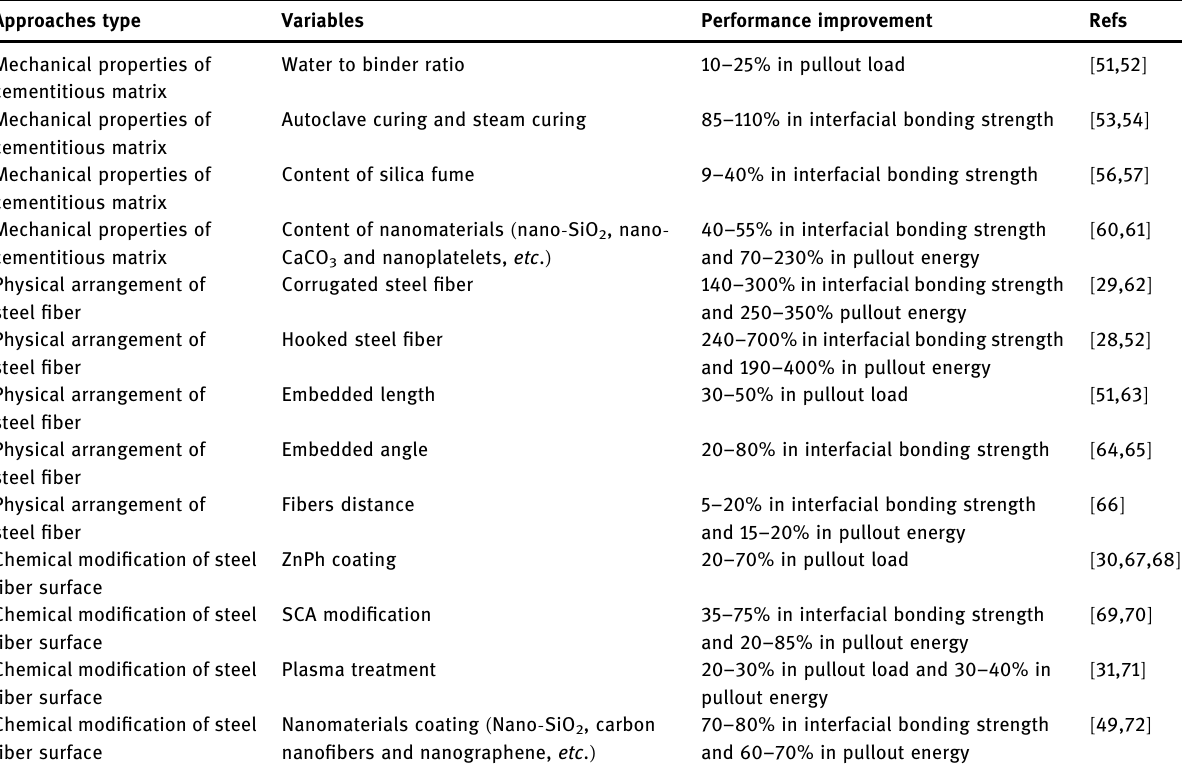
Table 1: E ff ect of various approaches on the interfacial performance enhancement of